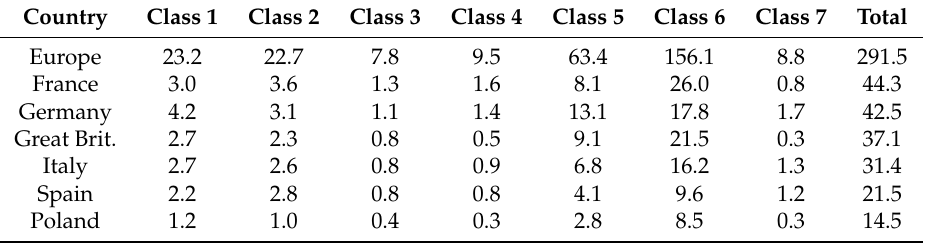
Table A2. DR potentials in GW. Adapted from Gils